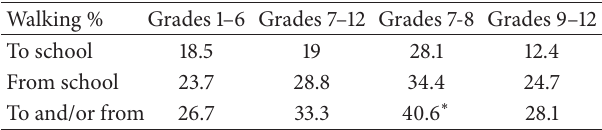
Table 2: Rates of walking to or back from